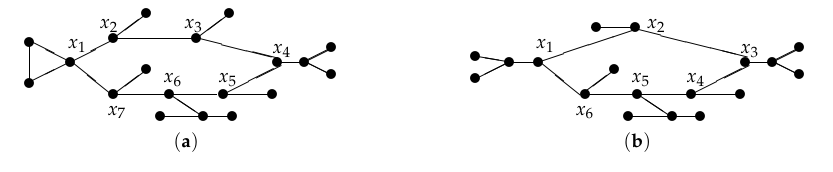
Figure 5. Examples of Lemma